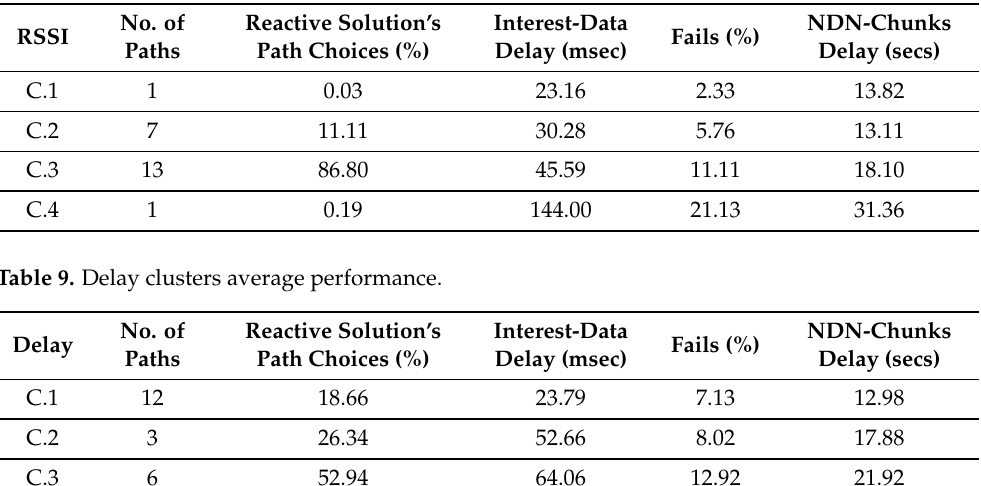
Table 8. RSSI clusters average performance.